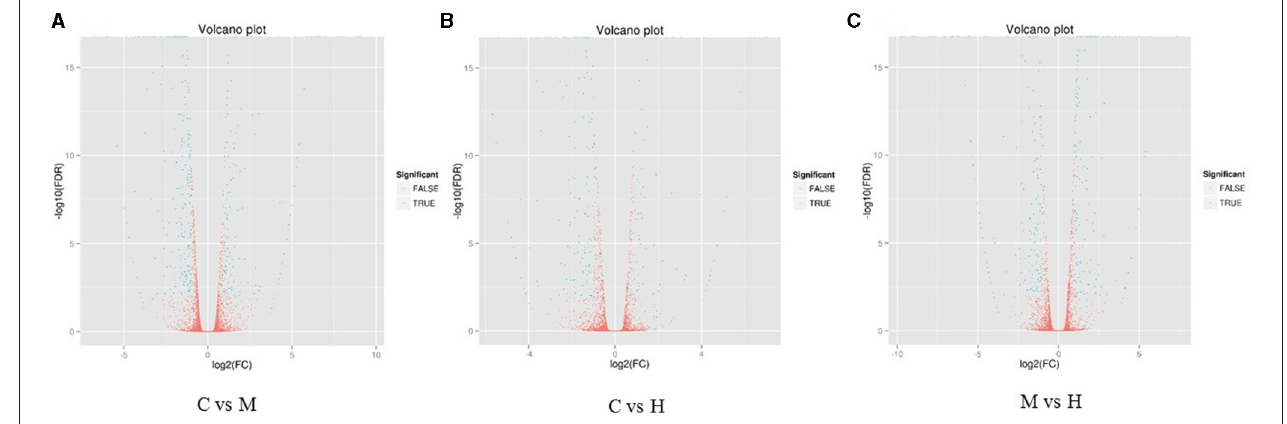
FIGURE 1 | Heat maps of DEGs in the comparison between C and M (A) , C and H (B) , and M and H (C) . X-axis shows log 2 (FC) of DEGs between each two samples. Y-axis indicates the –log 10 (FDR) of gene expression variations. Each point in the volcanic map represents a gene. The green dot represents the DEGs, and the red dot represents the non-DEGs.